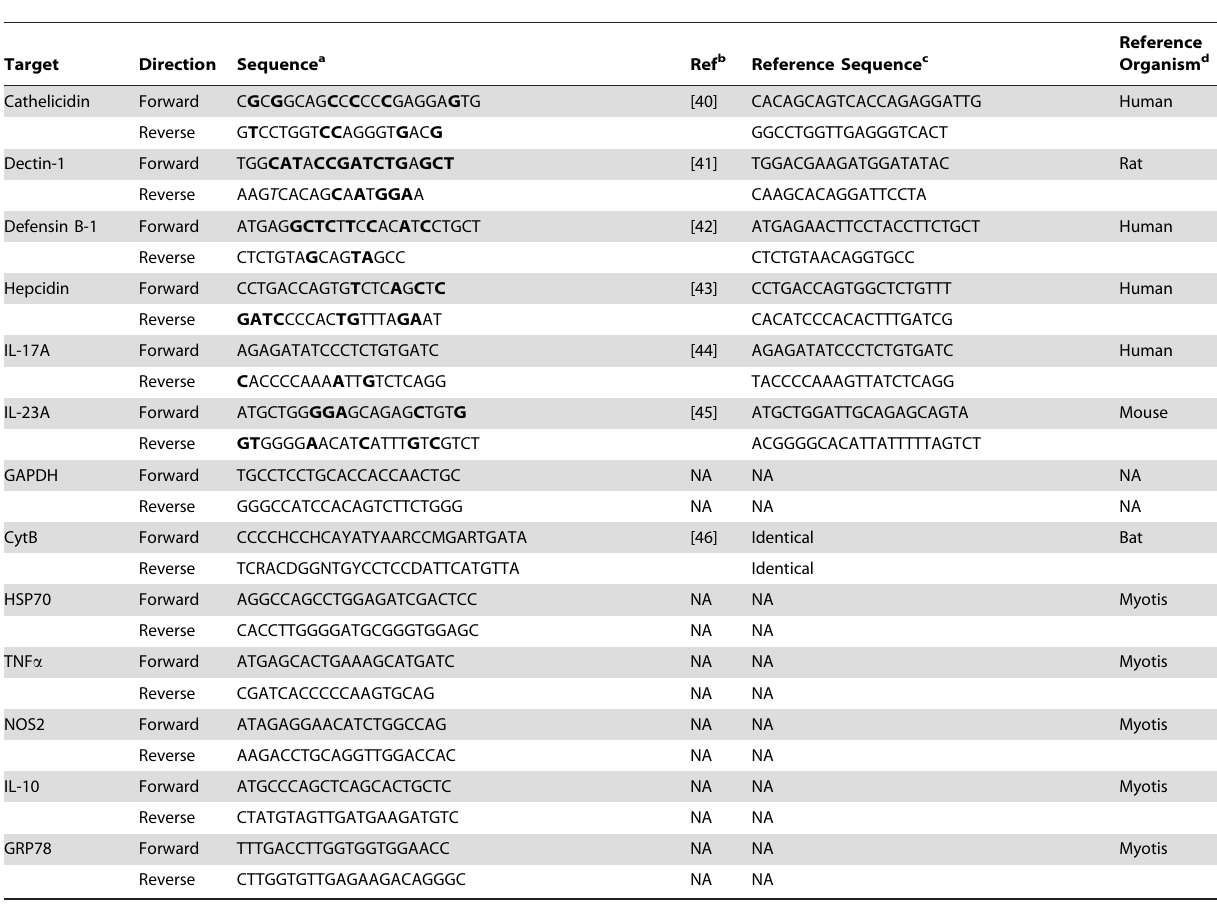
Table 1. Primer sequences used for quantitative RT-PCR estimation of Myotis lucifugus innate response genes.